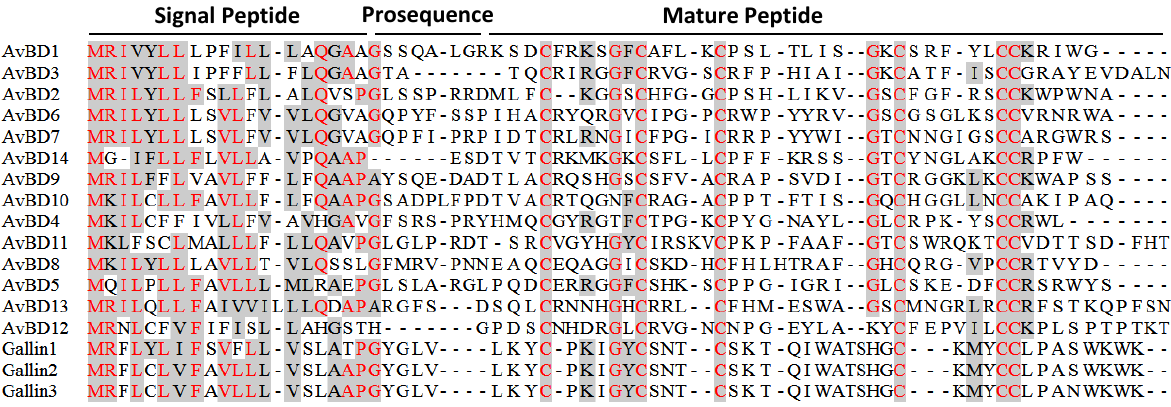
Figure 3. Amino acid sequence alignment of chicken β -defensins and ovodefensins. Conserved sequences are shaded and identical residues are in red. Dashes are created to maximize the alignment. Each β -defensin precursor is comprised of a conserved signal peptide, an optional short prosequence, and a C-terminal mature sequence consisting of six cysteines. Note that the cysteine spacing patterns are different between chicken ovodefensins (known as gallin 1–3) and classical β -defensins. Additional C-terminal tail sequences of AvBD3, 11, and 13 were omitted for